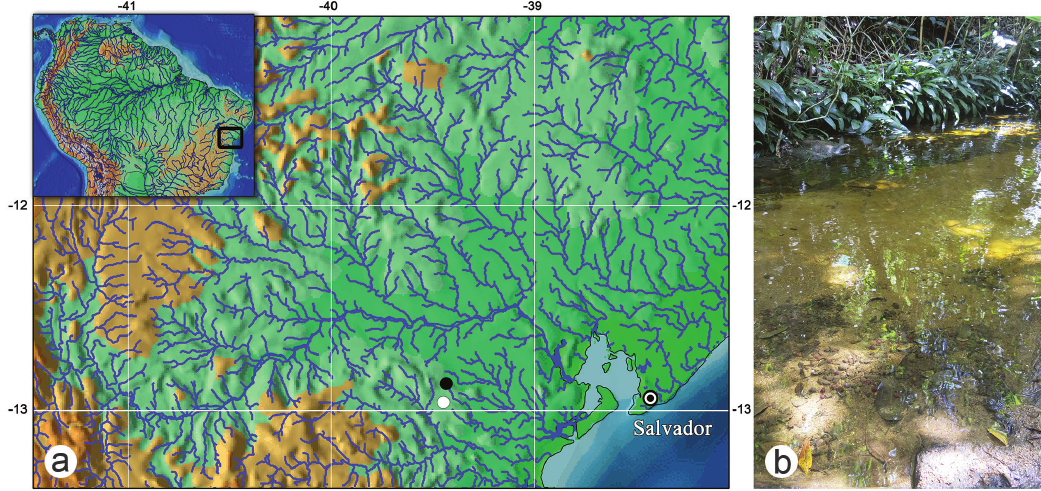
Fig. 6. (a) Map showing geographic distribution of Aspidoras kiriri (white dot represents type locality); (b) type